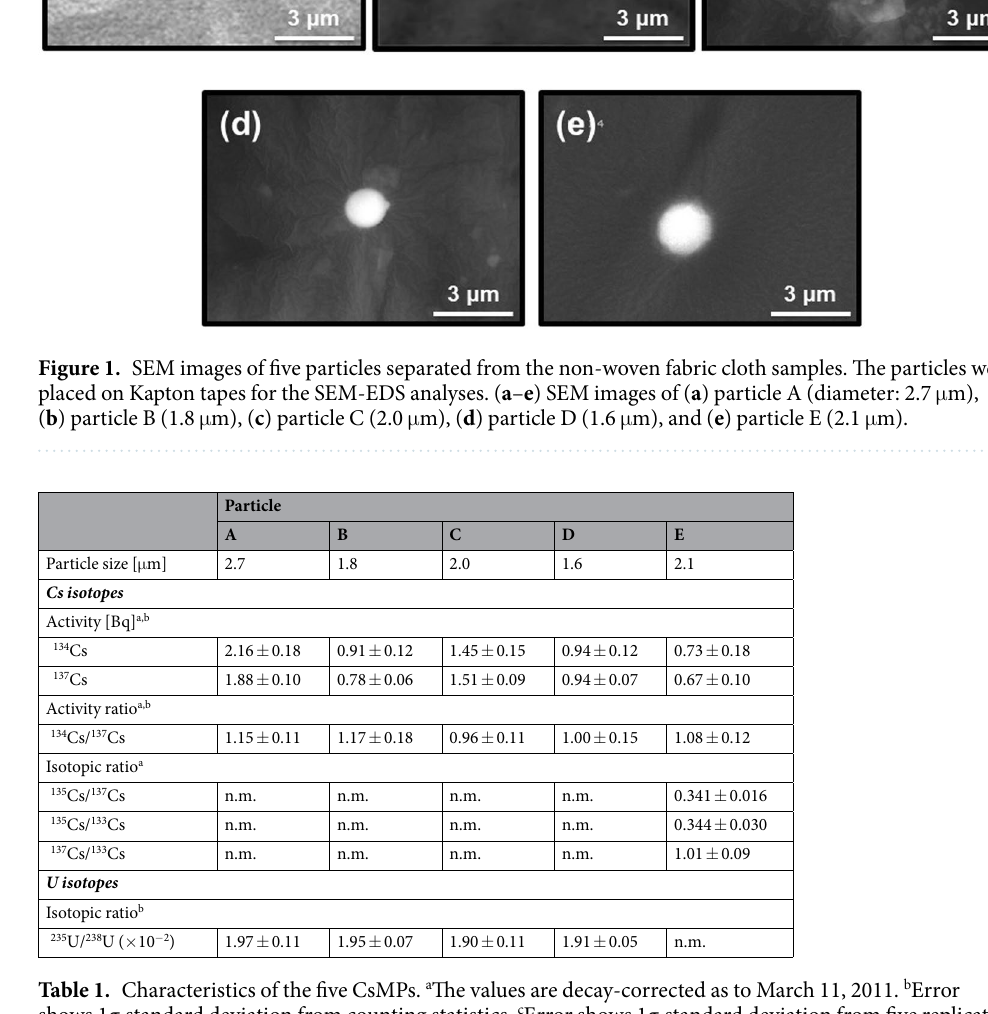
Figure 1a–e show the scanning electron microscopy (SEM) images of the particles. Particles A (Fig. 1a), B (Fig. 1b) and E (Fig. 1e) were isolated using the wet separation method, whereas particles C (Fig. 1c) and D (Fig. 1d) were separated using the dry separation method 15 . Some images have low resolution, but all particles presented almost spherical shapes with diameters of 1.6–2.7 μ m. The characteristics 0.67–1.88 Bq, respectively, as of March 11, 2011. The 137 Cs activity per unit volume in the particles were consist-